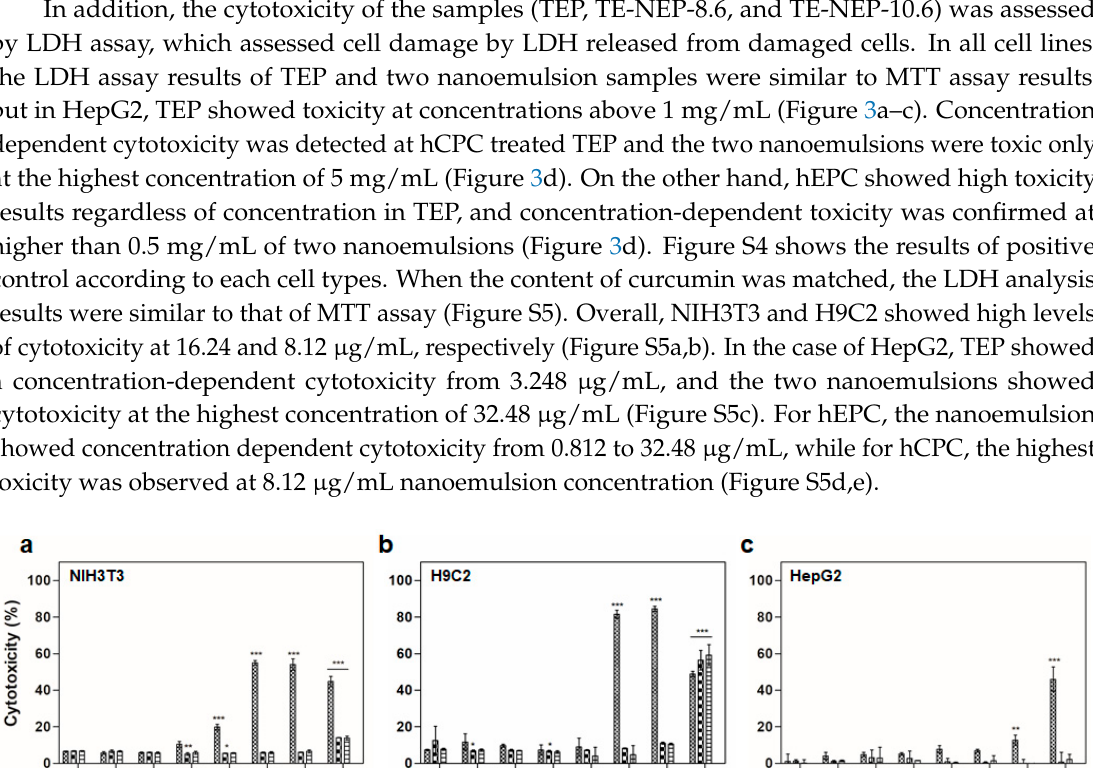
Figure 3. The cytotoxicity effects of TEP, TE-NEP-10.6 and TE-NEP-8.6 (0.025, 0.05, 0.1, 0.25, 0.5, 1 and 5 mg/mL) on ( a ) NIH3T3, ( b ) H9C3, ( c ) HepG2, ( d ) hCPC and ( e ) hEPC. Cell death was measured with the LDH assay after 24 h. Experiments were repeated 3 times independently. *, **, *** p < 0.05, compared to the control.